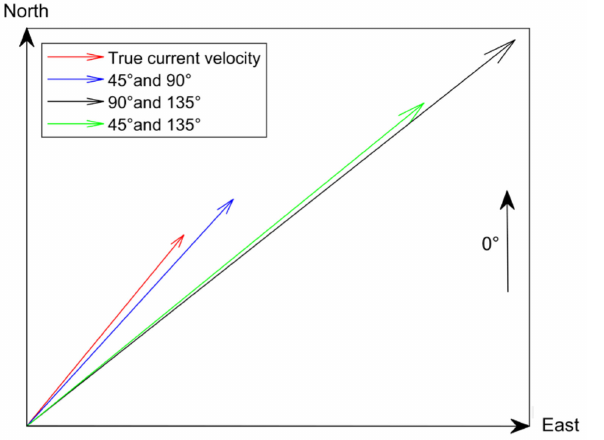
Figure 9. Comparison of current velocity inversion results using different observation azimuth